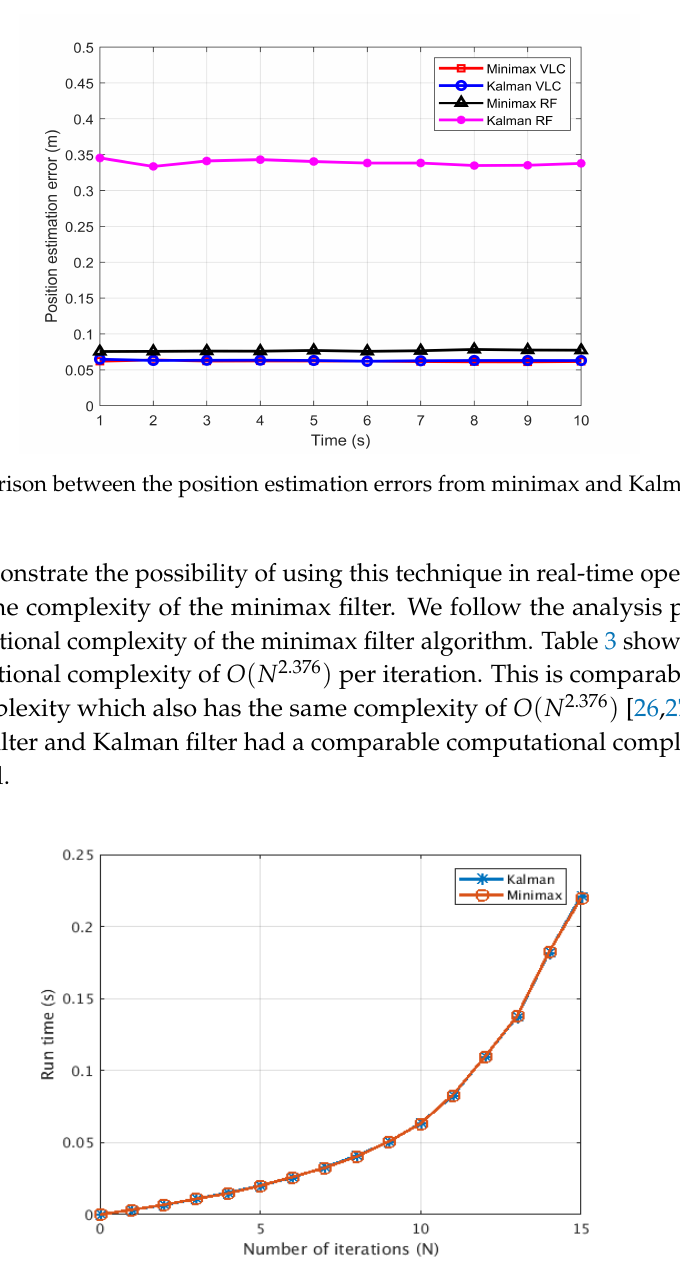
Figure 9. The computational complexity of the minimax filter